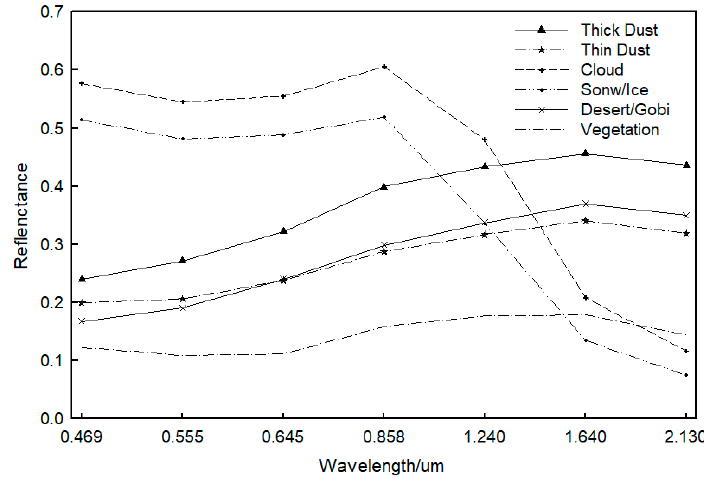
Figure 1. The spectrum of different targets at MODIS bands 1–7.